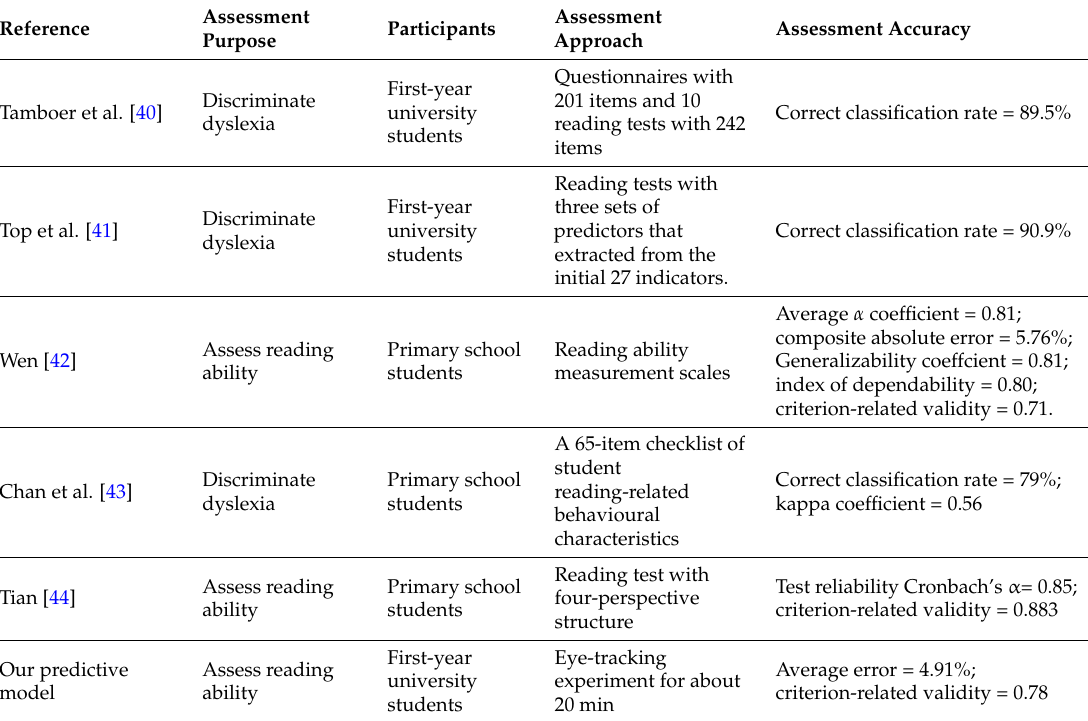
Table 2. Comparison of assessment